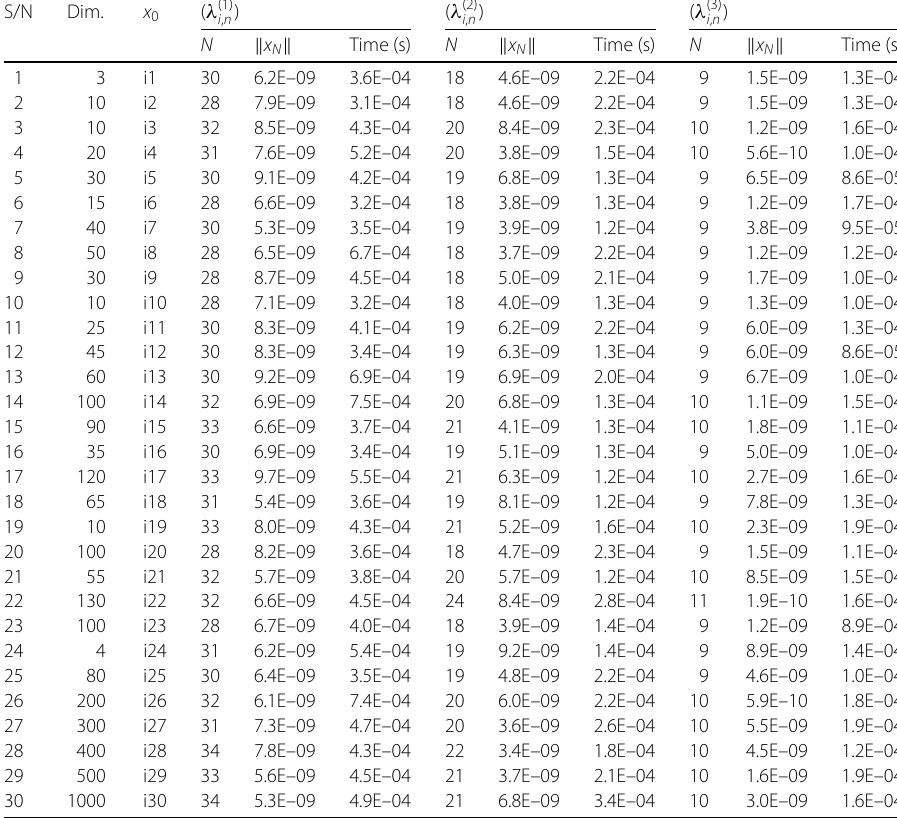
), ( λ (2) ) and ( λ (3) ) i , n i , n i , n